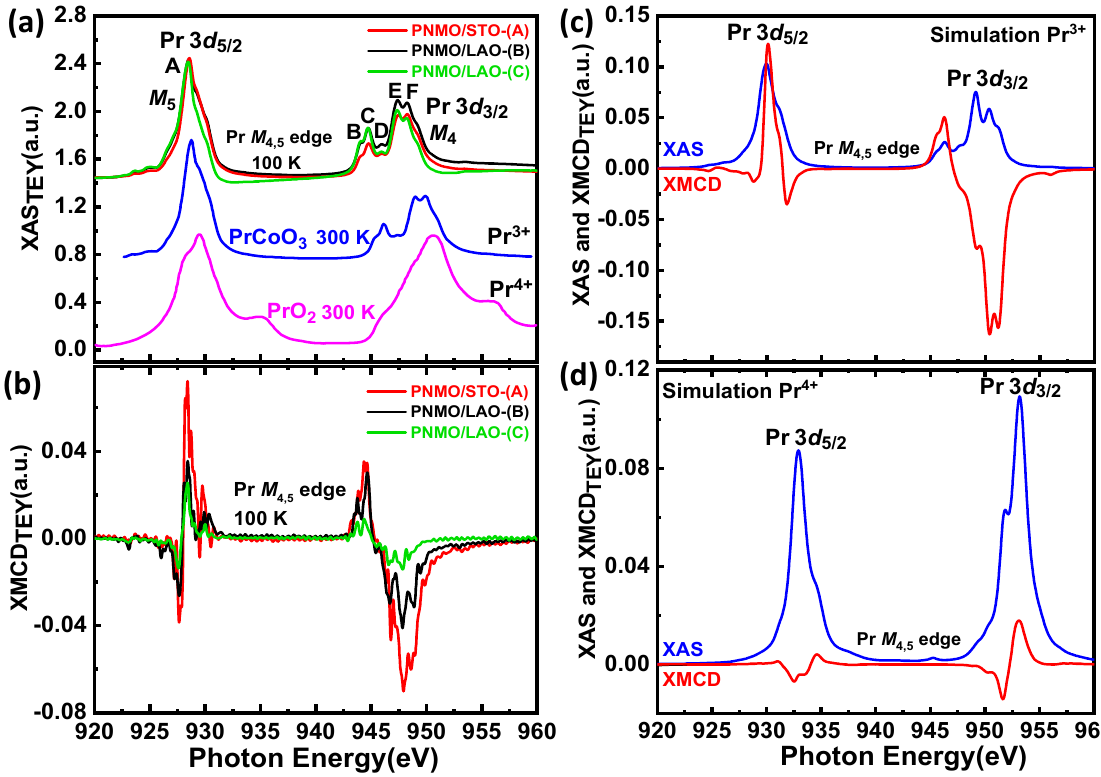
Figure 9. ( a ) Pr M 4,5 XAS for PNMO/STO-(A), PNMO/LAO-(B), and PNMO/LAO-(C) as collected at T = 100 K. For comparison, the XAS spectra of PrCoO 3 (Pr 3+ ) and PrO 2 (Pr 4+ ) at T = 300 K are also shown [74–76]. ( b ) Corresponding XMCD spectra under 2 T. ( c , d ) Calculated Pr M 4,5 XAS and XMCD spectra for Pr 3+ and Pr 4+ isolated cations, respectively.